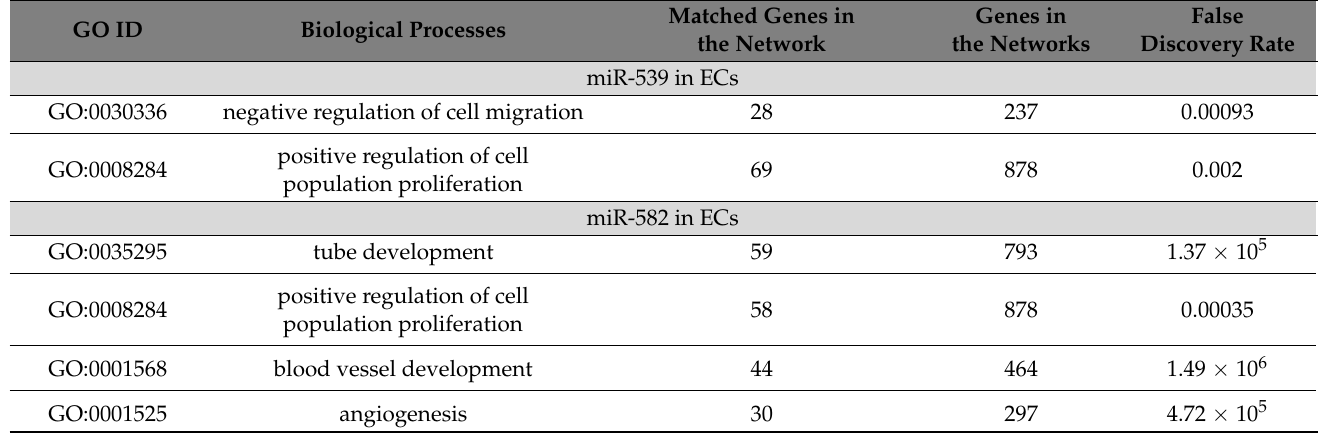
Figure 4. miR-539 and miR-582 regulate genes involved in angiogenesis-related biological processes in ECs and SMCs. ( a , d ) Transcriptomic analysis of ECs transfected with pre-miR-539 ( a ) and pre- miR-582 ( b ) and SMCs transfected with pre-miR-539 ( c ) and pre-miR-582 ( d ). Pie chart shows all significant regulated genes ( p < 0.05) analyzed by RNA sequencing with the number of upregulated genes colored in red while downregulated genes are labeled in blue. Light blue shows number of potential microRNA targets. ( e – h ) Validation of some putative targets by qPCR. ( e ) ECs were transfected with pre-miR-control or pre-miR-539. ( f ) ECs were transfected with pre-miR-control or pre-miR-582. ( g ) SMCs were transfected with pre-miR-control or pre-miR-539. ( h ) SMCs were transfected with pre-miR-control or pre-miR-582. All data are the mean ± SD ( n = 3 independent experiments). * p < 0.05, ** p < 0.01, and *** p < 0.001 vs. the respective control. Table 1. miR-539 and miR-582 target many genes in ECs and SMCs. Genes regulated by miR-539 and miR-582 in ECs and SMCs according to the data obtained by RNA sequencing. Data were compared with the lists of predicted target genes available on TargetScan and then analyzed with Gene Ontology to highlight the biological processes where identified target genes are